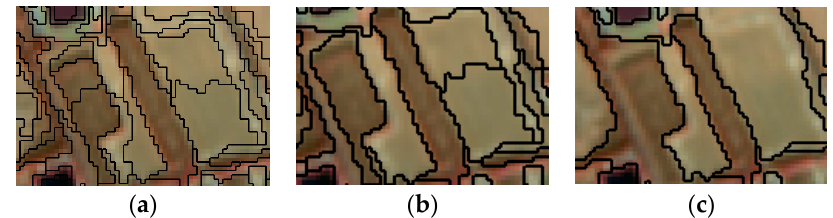
Figure 3. Different segmentation scale. ( a ) The weight of the shape factor is 0.2, the weight of the spectral feature is 0.8, the segmentation scale is 15. ( b ) The weight of the shape factor is 0.2, the weight of the spectral feature is 0.8, the segmentation scale is 25. ( c ) The weight of the shape factor is 0.2, the weight of the spectral feature is 0.8, the segmentation scale is 35.